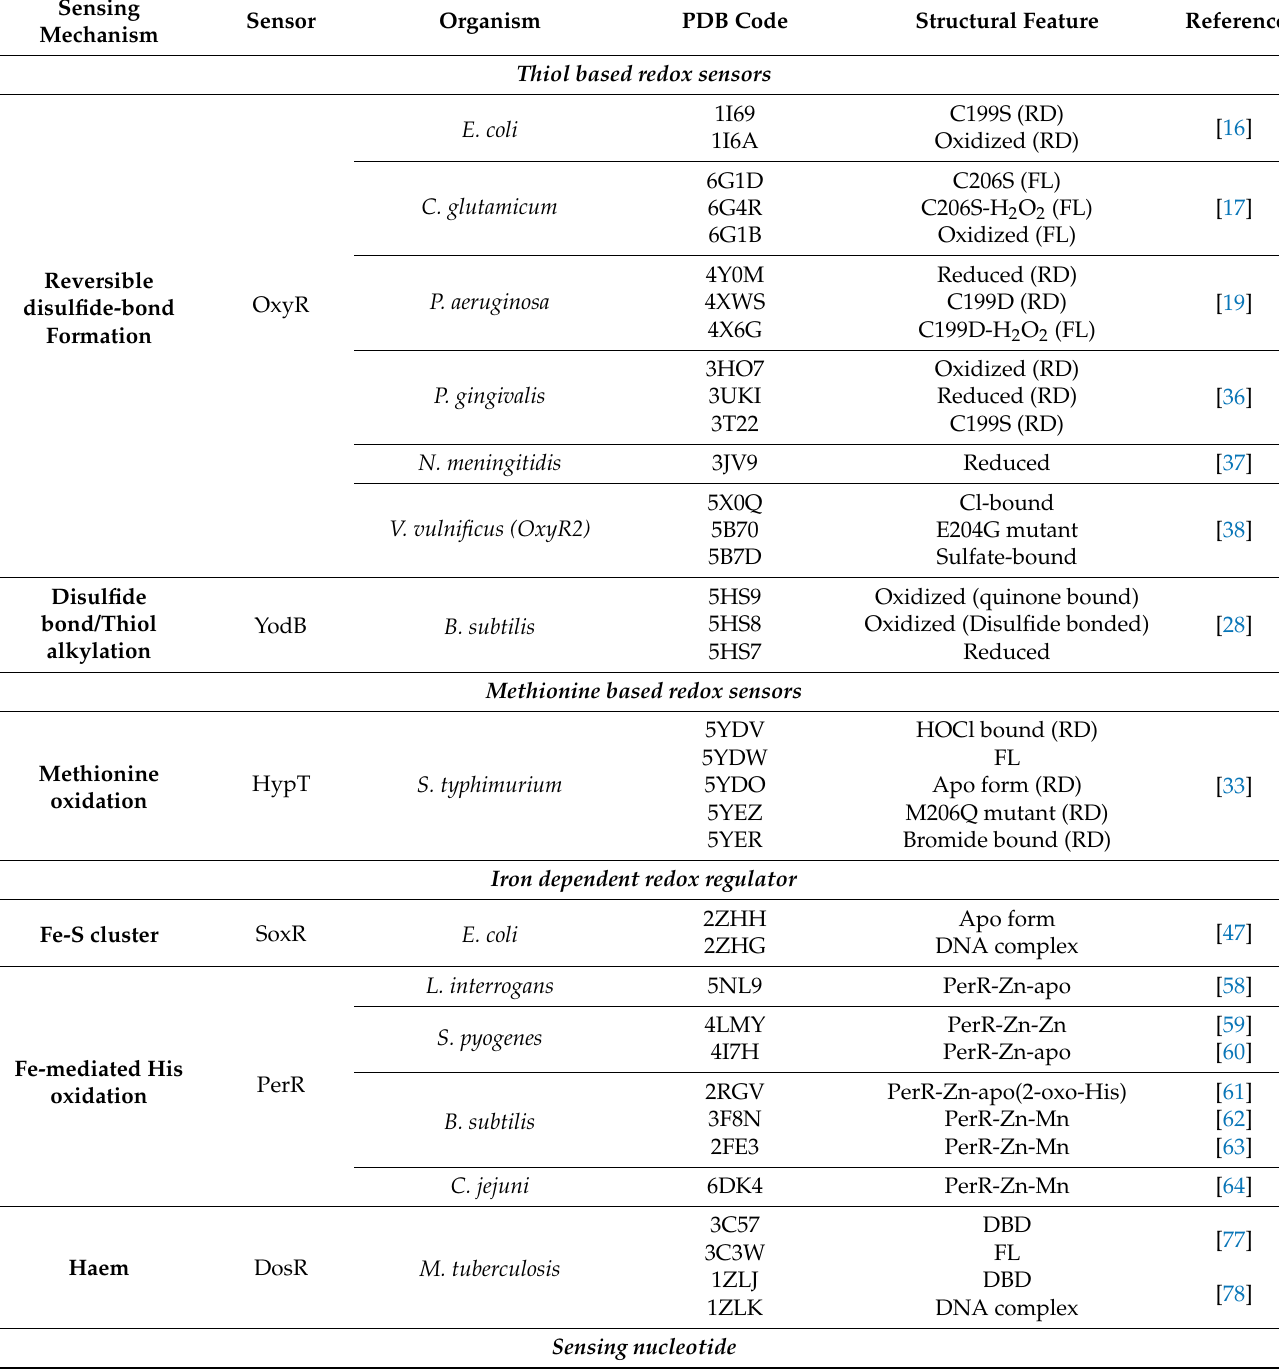
Table 1. Bacterial redox sensors . Abbreviations: RD, Regulatory domain; DBD, DNA binding domain; FL, Full-length; P. gingivalis , Porphyromonas gingivalis ; P.aeruginosa , Pseudomonas aeruginosa ; E. coli , Escherichia coli ; C glutamicum , Corynebacterium glutamicum ; N. meningitidis , Neisseria meningitidis ; V. vulnificus , Vibrio vulnificus ; B. subtilis , Bacillus subtilis ; S. typhimurium , Salmonella typhimurium ; L. interorgans , Leptospira interrogans ; S. pyogenes , Streptococcus pyogenes ; C. jejuni , Campylobacter jejuni ; M. tuberculosis , Mycobacterium tuberculosis ; A.vinelandii , Azotobacter vinelandii ; T. aquaticus , Thermus aquaticus ; T. thermophilus , Thermus thermophilus ; T. maritima , Thermotoga maritima